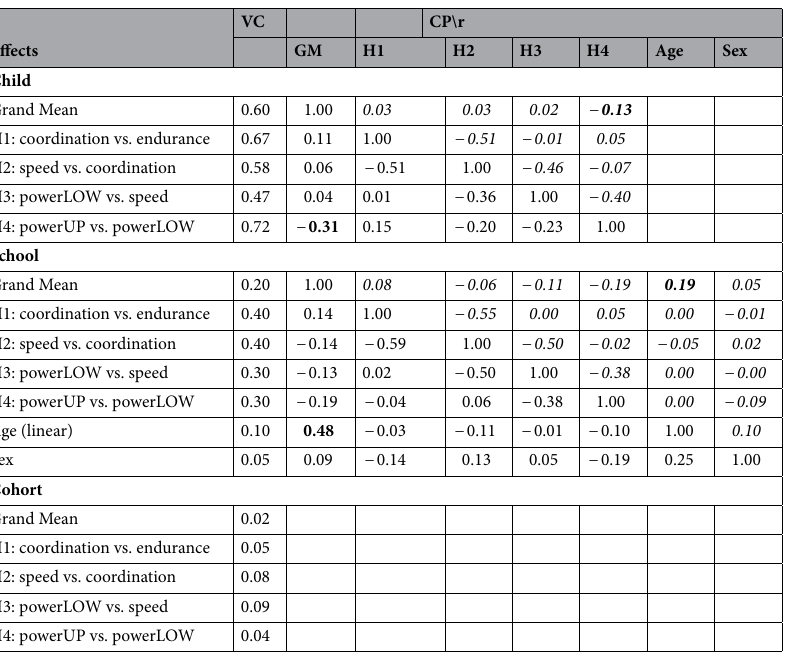
Table 3. Variance components, correlation parameters, and zero-order correlations for test-related contrasts. H1 to H4 = hypothesis 1–4, endurance = cardiorespiratory endurance (i.e., 6 min run test), coordination = star run test, speed = 20-m linear sprint test, powerLOW = power of lower limbs (i.e., standing long jump test), powerUP = power of upper limbs (i.e., ball push test), VC = sqrt (variance component), CP\r = correlation parameter\zero-order correlation; linear mixed model correlation parameters are shown in upright and corresponding pairwise zero-order correlations in italics for children (top) and schools (middle). Theoretically relevant correlations discussed in the text are set in bold . VC for Residual = 0.54. VCs and CPs are based on full set of data; ZOC correlations are based on subsets of data (Child: 96,529 children from 512 schools; School: 93,661 children from 421